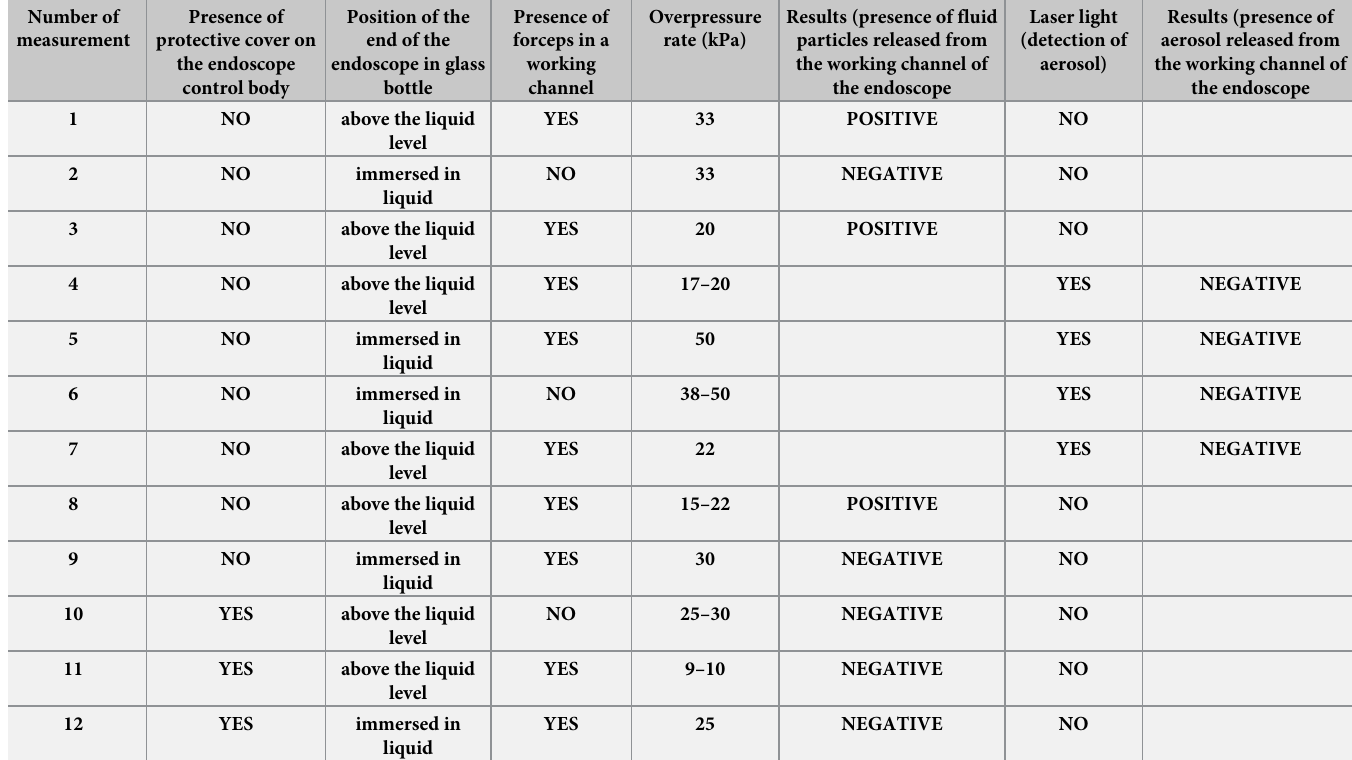
Table 1. Results of